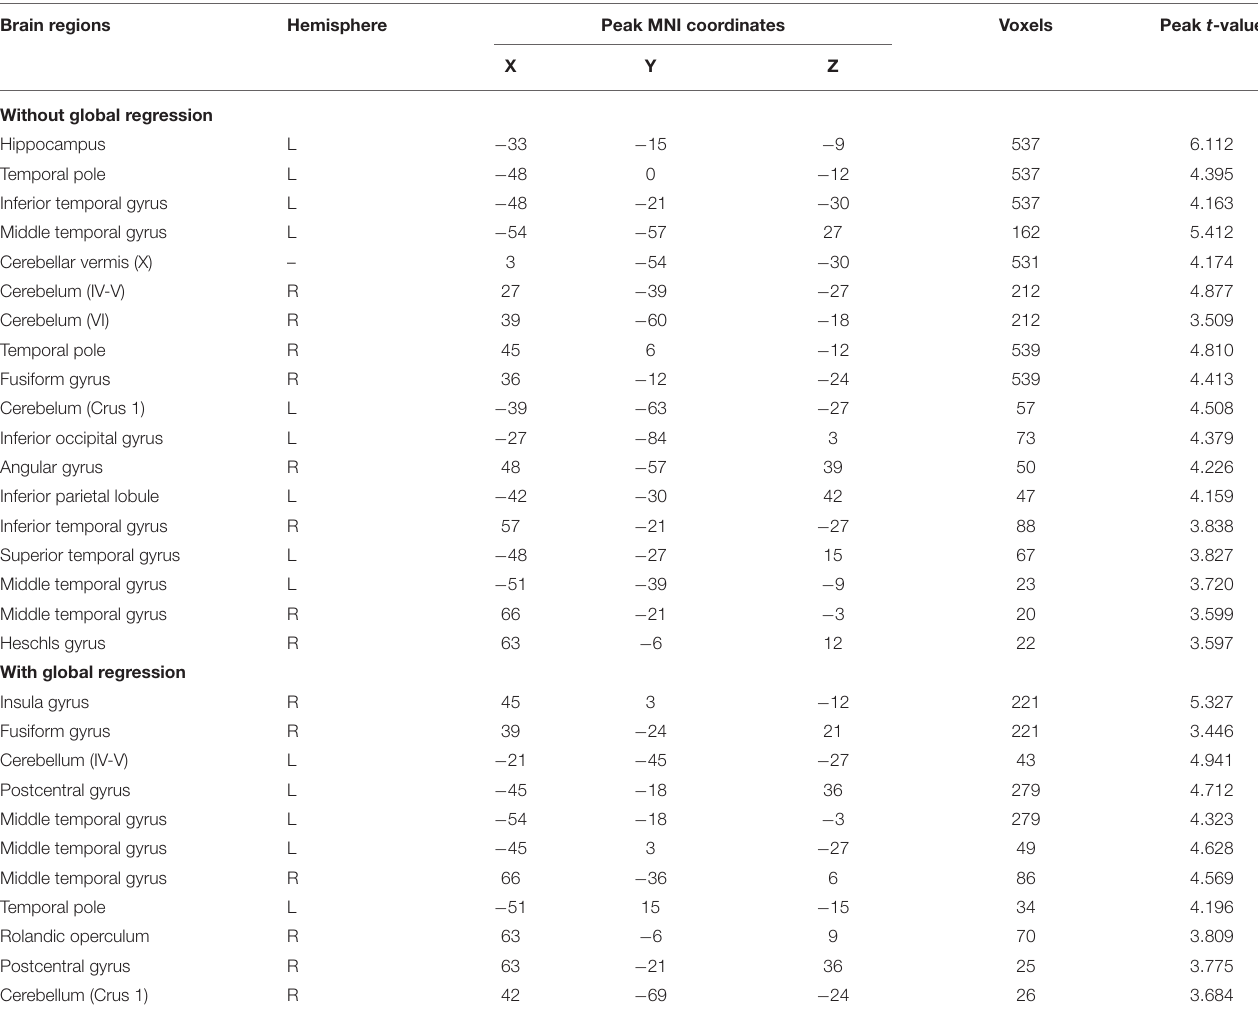
TABLE 3 | Between-group comparison of the CV of ReHo across sliding windows. Brain regions Hemisphere